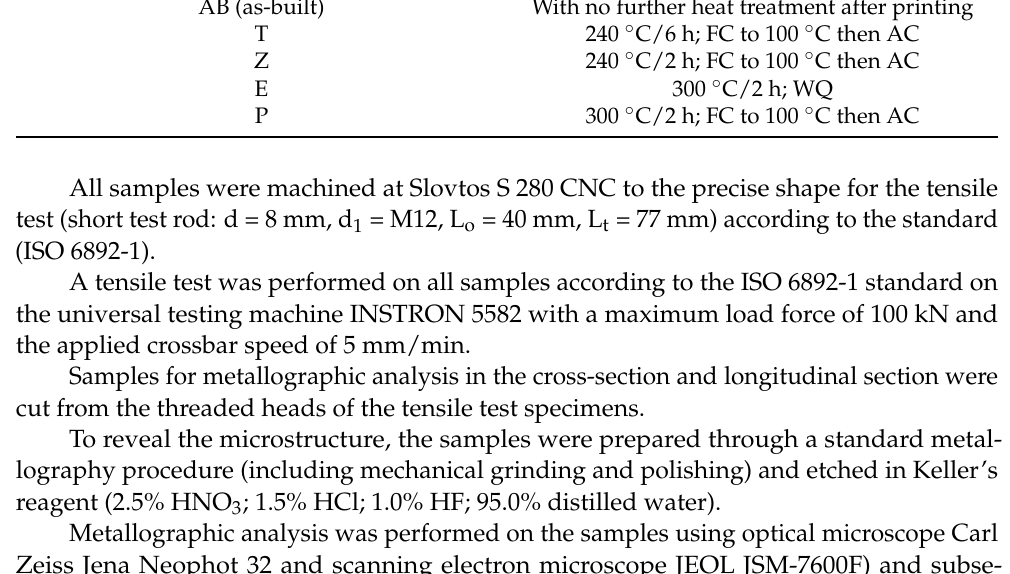
Table 3. List of heat treatment modes of L-PBF AlSi10Mg used in the experiment. Identification of the Sample Group Description of the Heat Treatment AB (as-built) With no further heat treatment after printing T 240 ◦ C/6 h; FC to 100 ◦ C then AC Z 240 ◦ C/2 h; FC to 100 ◦ C then AC